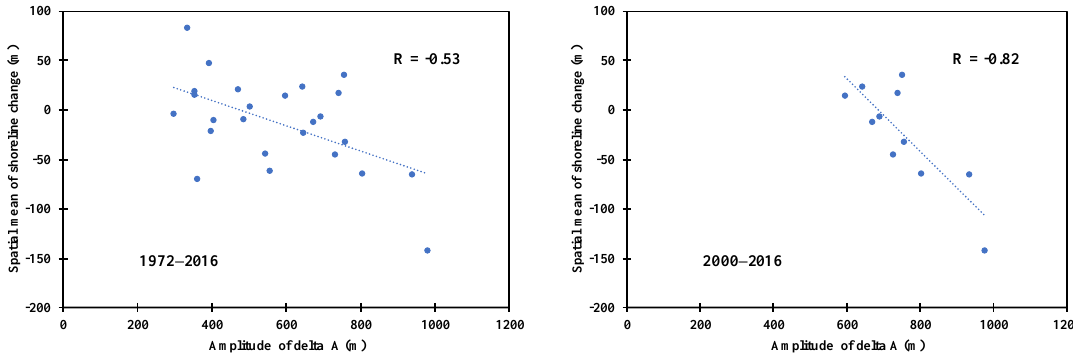
Figure 18. Variation in the spatial mean of the shoreline change from the toe to 2 km downcoast of the sand spit.